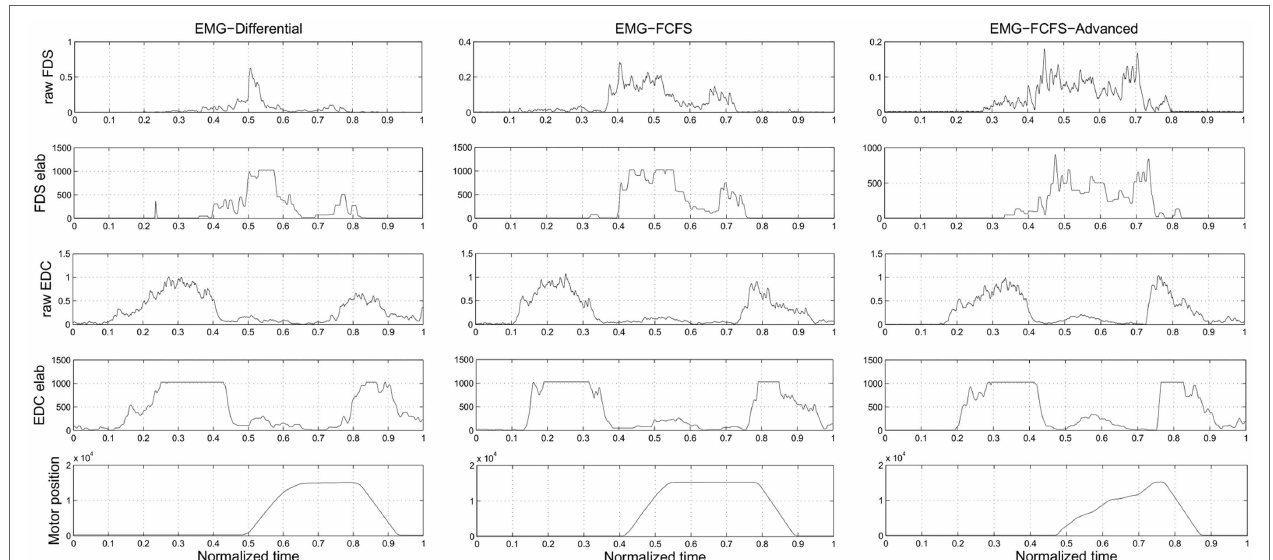
FIGURE 4 | Experiment 3 : this picture presents how the different algorithms manage the EMG signals . The plots of the real EMG signals, the EMG signals after the elaboration, and the application of the thresholds inside the SH-P firmware and the motor positions are presented. The presented data are obtained during a real trial of Experiment 3.